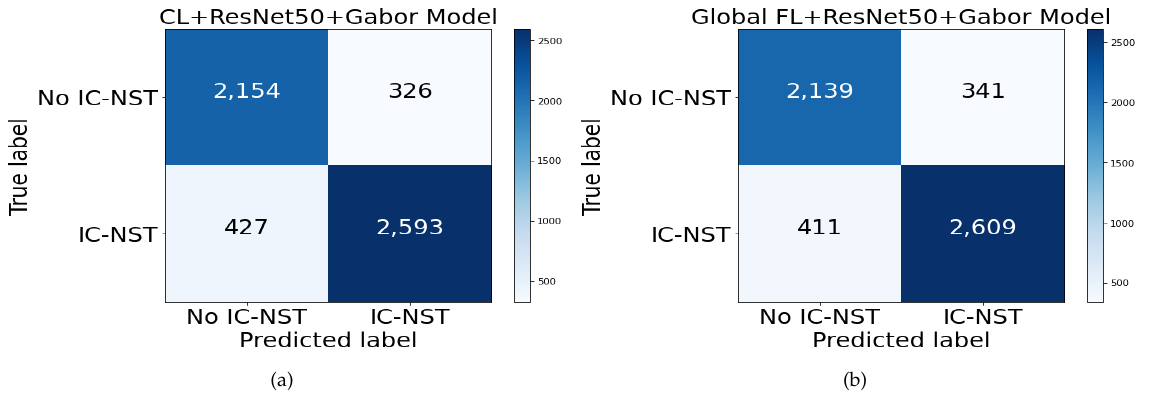
Figure 8. Confusion matrix for BreakHis dataset on ( a ) CL + ResNet50 + Gabor and ( b ) FL + ResNet50 + Gabor models.